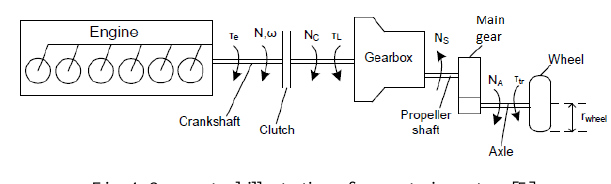
Fig. 4. Conceptual illustration of powertrain system